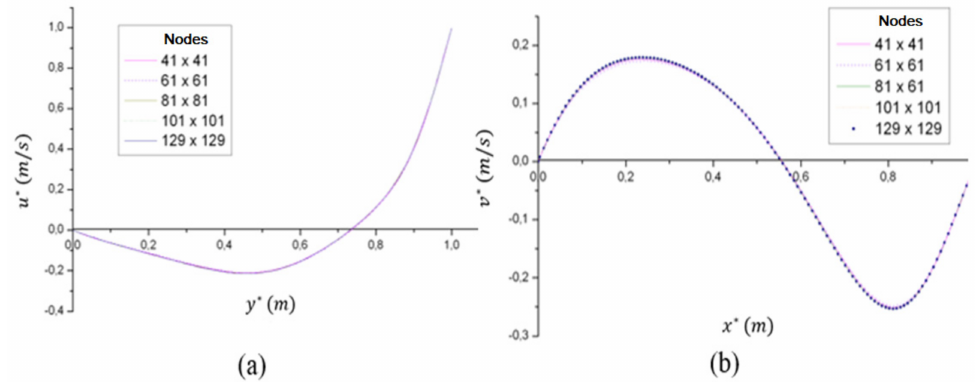
Figure 6. Velocity distribution for different mesh sizes; ( a ) spatial mesh for u . ( b ) spatial mesh for v .